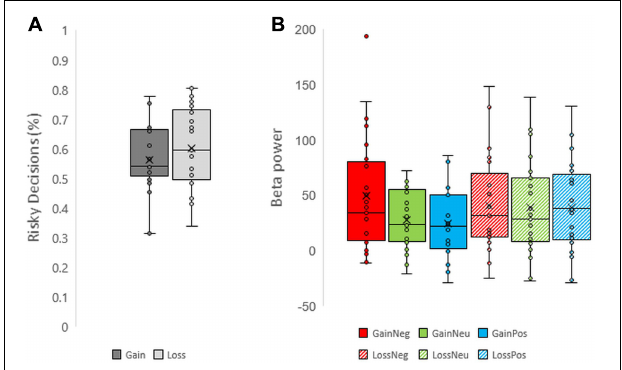
FIGURE 2 | Boxplots representing (A) risky decision making across valence and (B) beta power across each condition for each